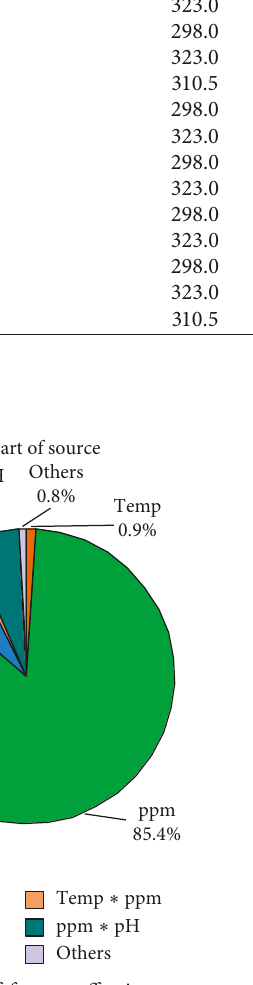
Figure 1: Pie chart of factors affecting q